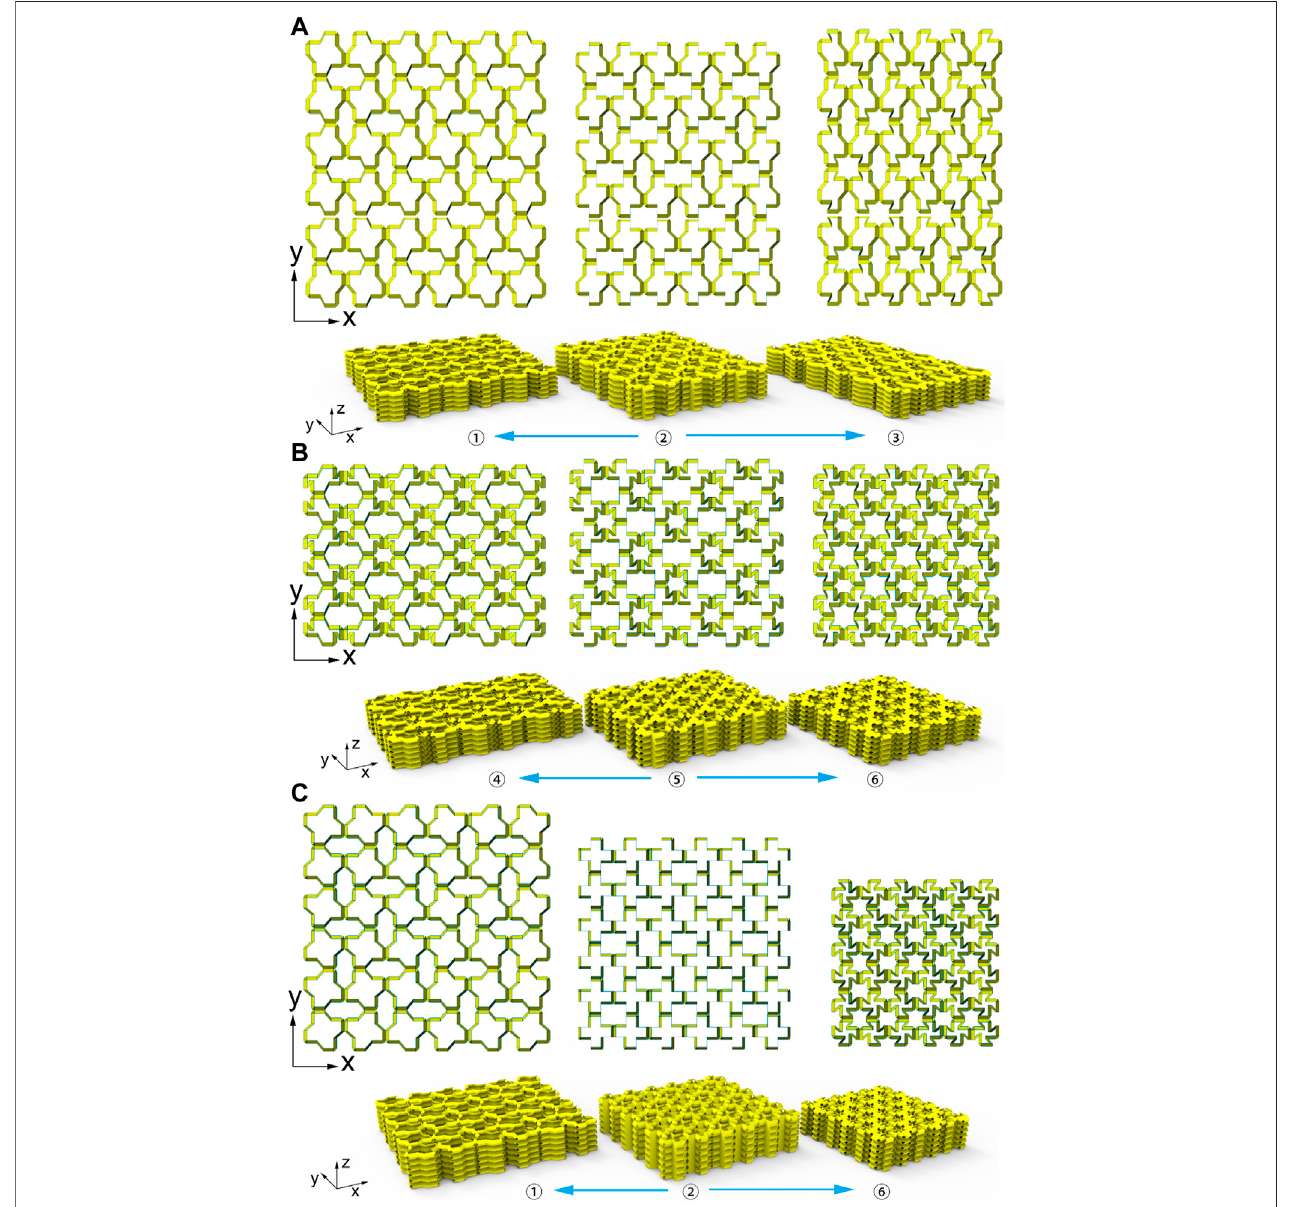
FIGURE 7 | Three patterns of 3D cellular structures. (A) Deformation paths ② → ① and ② → ③ with γ 1 (cid:1) 45 ° and γ 2 (cid:1) 60 ° . (B) Deformation paths ⑤ → ④ and ⑤ → ⑥ with γ (cid:1) 45 ° and γ (cid:1) 60 ° . (C) Deformation paths ② → ① and ② → ⑥ with γ 1 2 (C) . Top: 2D metamaterials with 6 × 6 units. Bottom: 3D metamaterials with 6 × 6 × 6